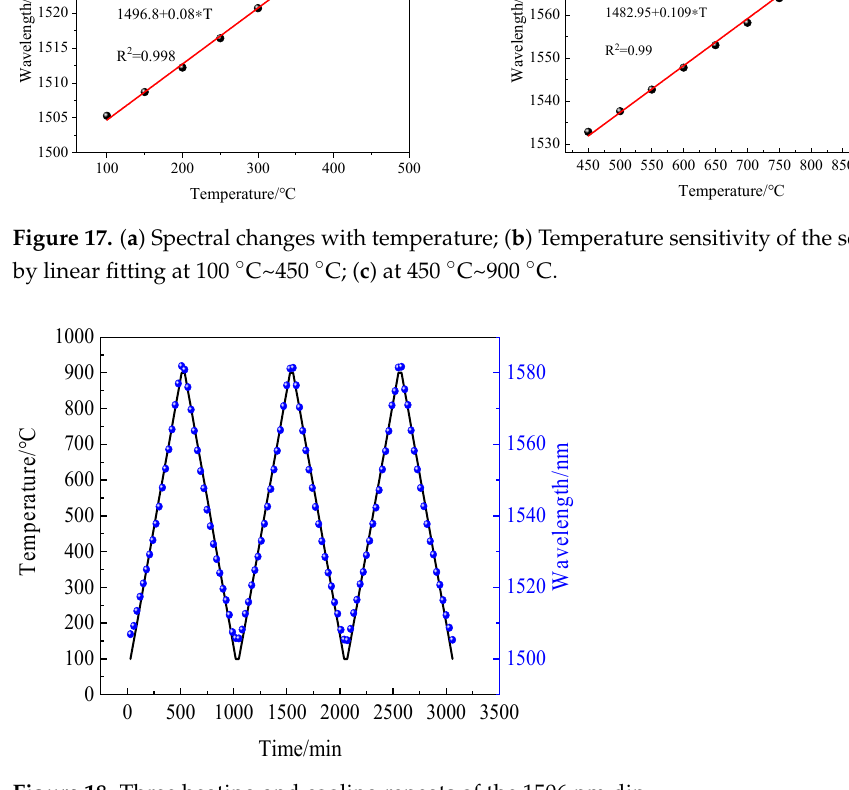
Figure 19. ( a ) Mean and standard deviation of the temperature dependence of the 1506 nm dip; ( b ) Mean and standard deviation of the 1506 nm dip at 900 °C. Many scholars have made contributions to the research of fiber temperature sensors. Table 2 summarizes the sensitivity, measurement range, and fabrication methods of the fiber optic temperature sensors reported in this work and previous literature. In this pa- per, we use a simple fabrication method to achieve the measurement of 100 °C to 900 °C with an SMF optic sensor. Table 2. Comparison of the fiber temperature sensors. Authors